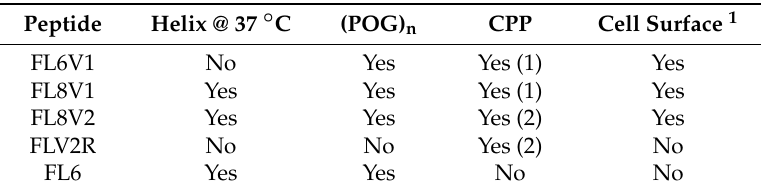
Table 2. Properties of collagen/CPP hybrid